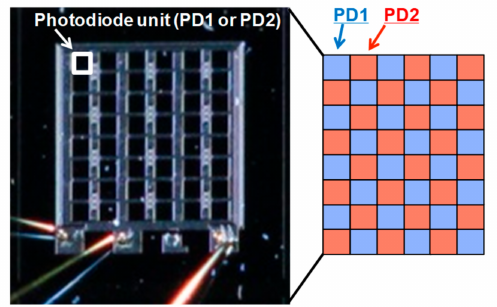
Figure 9. Chip micrograph, showing the employed checker pattern of 8 × 6 photodiode units. Table 3. Samples manufactured for evaluation and comparison with simulation results.